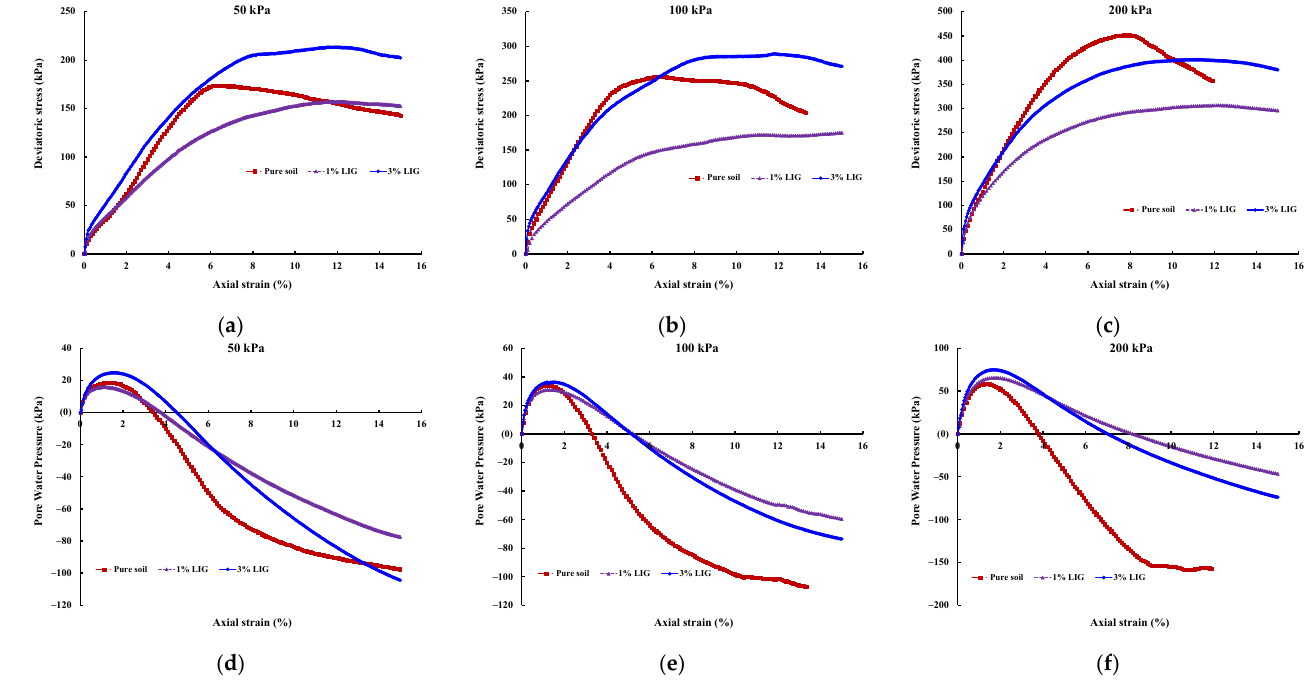
Figure 4. Results of CU triaxial tests, deviatoric stress-axial strain curves for ( a ) 50 kPa confining pressure; ( b ) 100 kPa confining pressure; ( c ) 200 kPa confining pressure; and pore water pressures for ( d ) 50 kPa confining pressure; ( e ) 100 kPa confining pressure; ( f ) 200 kPa confining